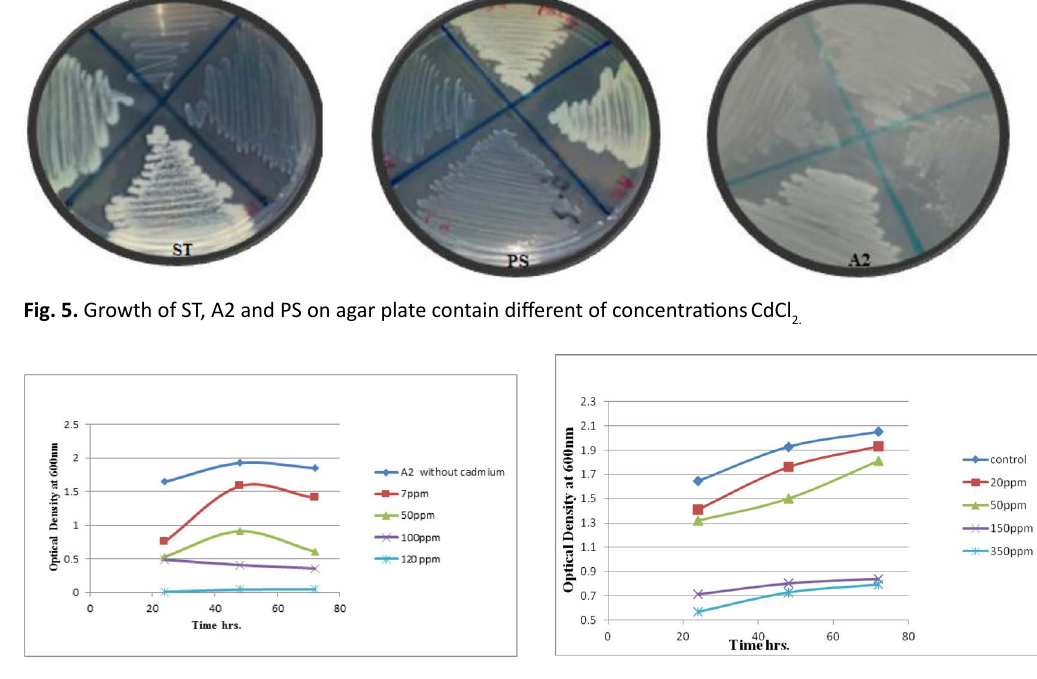
Fig. 6. Growth curve of isolate A2 with (CdCl different